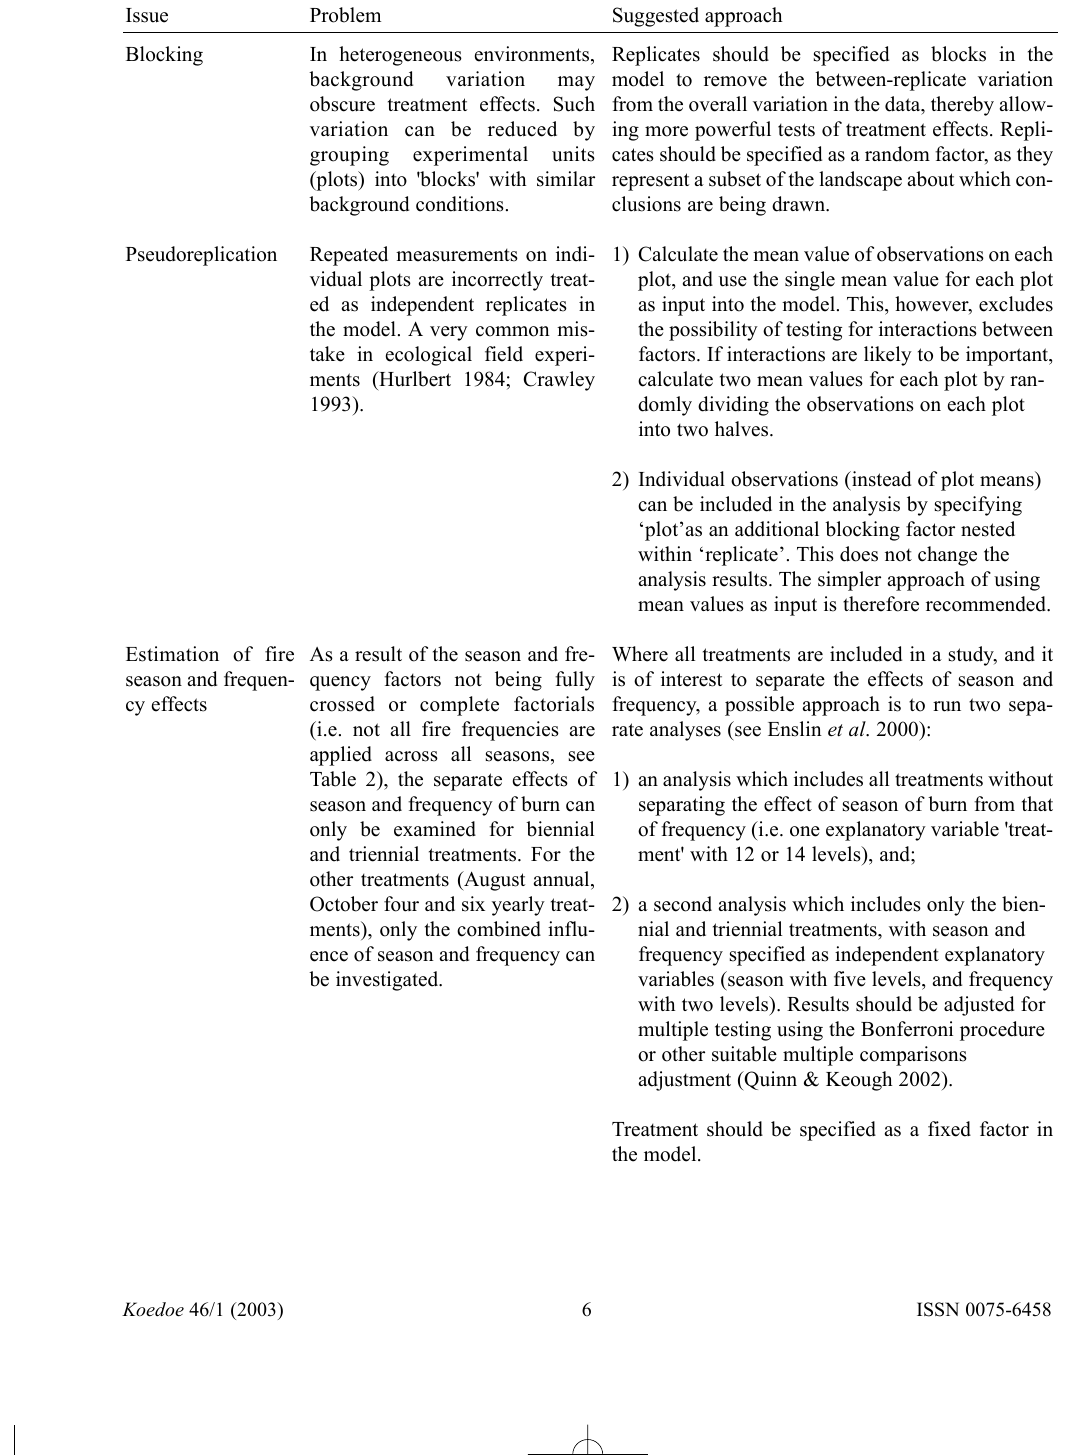
Suggestions for model specification when analysing EBP data using Analysis of Variance (ANOVA). These model elements apply more broadly to the specification of generalised linear models, such as log-linear and logistic models. The suggestions below relate to the analysis of data from a single landscape. When analysing data from multiple landscapes, model specification becomes more complex (see